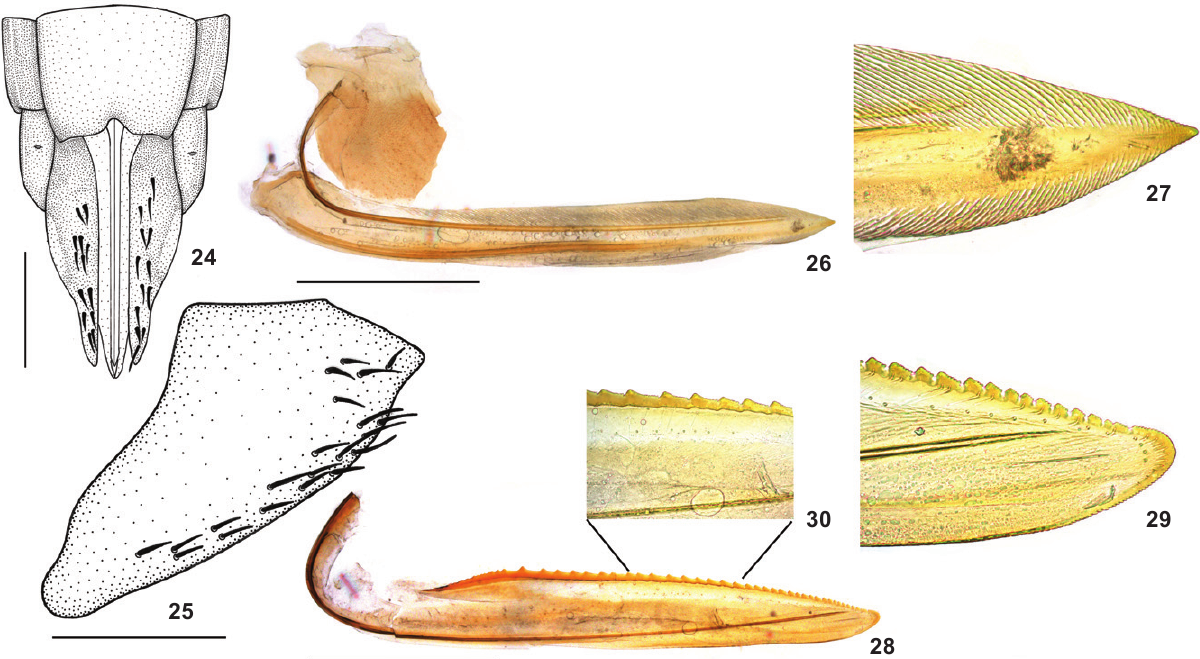
Figures 24-30. Ruppeliana flavivirescens sp. nov. , female paratype: (24) apical portion of abdomen, ventral view; (25) pygofer, lateral view; (26) first valvula and valvifer, lateral view; (27) apex of first valvula in higher magnification; (28) second valvula, lateral view; (29) apex of second valvula in higher magnification; (30) teeth of second valvula in detail. Scale bars = 1.0